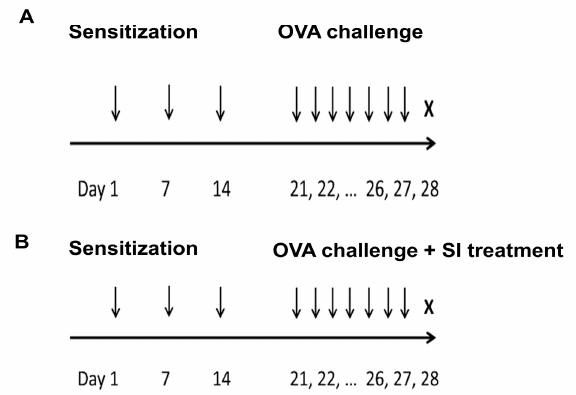
Figure 1. Protocol for the induction of colitis and sirtuin 7 (SIRT7) inhibitor treatment in mice. ( A ) The timeline illustrates that colitis mice were intraperitoneally injected with ovalbumin (OVA) and subsequently intranasally administered OVA from days 21 to 27. Mice were sacrificed on day 28. ( B ) Mice of the SIRT7 inhibitor-treated group were treated with SIRT7 inhibitor (SI). Mice were intranasally challenged with SIRT7 inhibitor and OVA every alternate day from days 21 to 27. Mice were sacrificed on day 28.